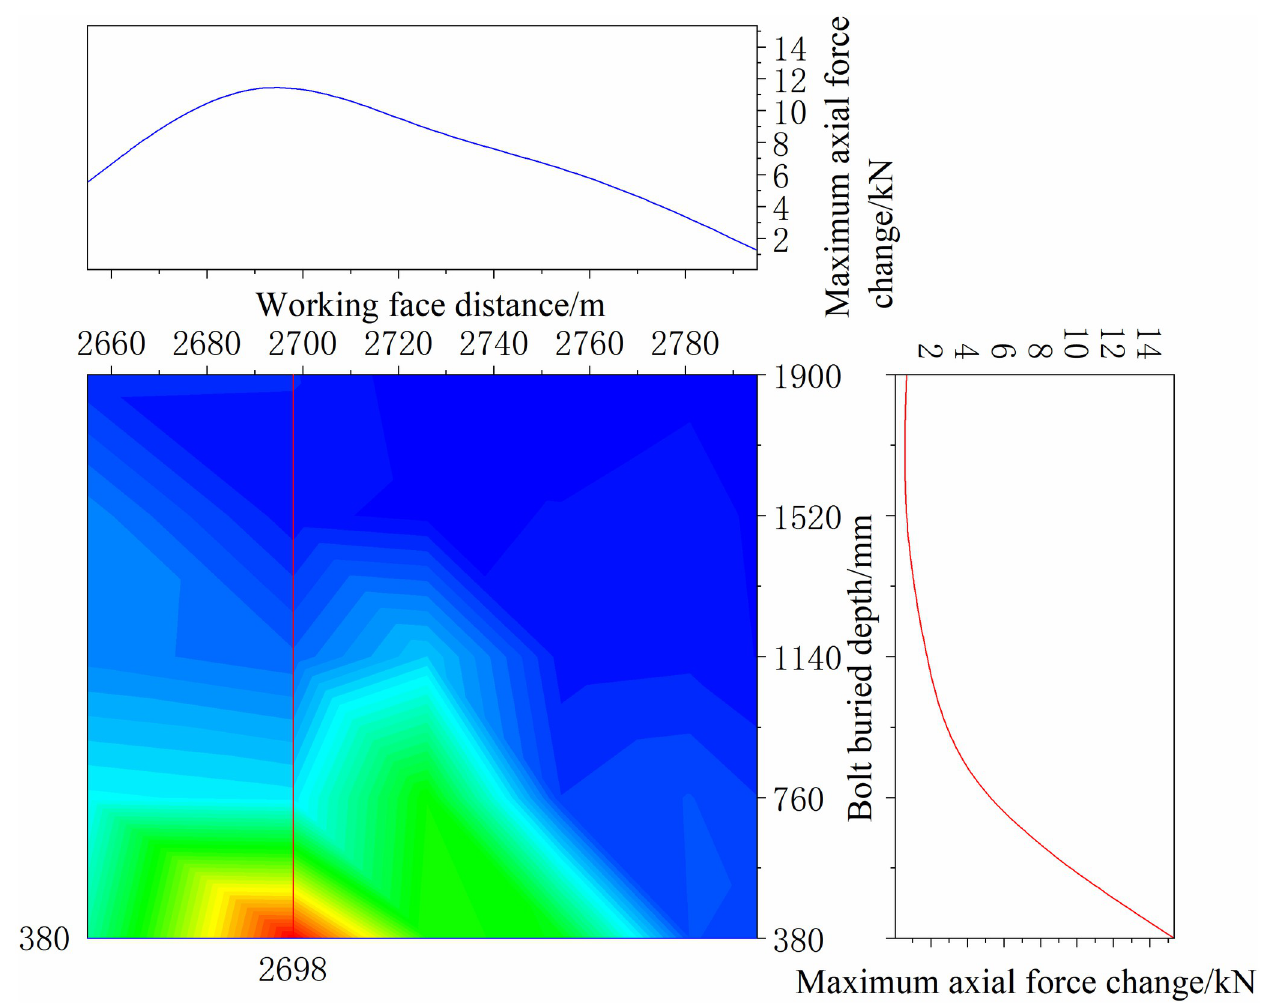
Fig 37. Continuously distributed contour profile curves of bolt monitoring data of negative bolt.